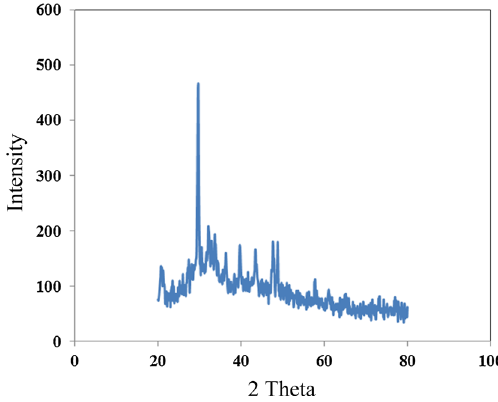
Fig. 13 XRD pattern of AEM facing middle chamber